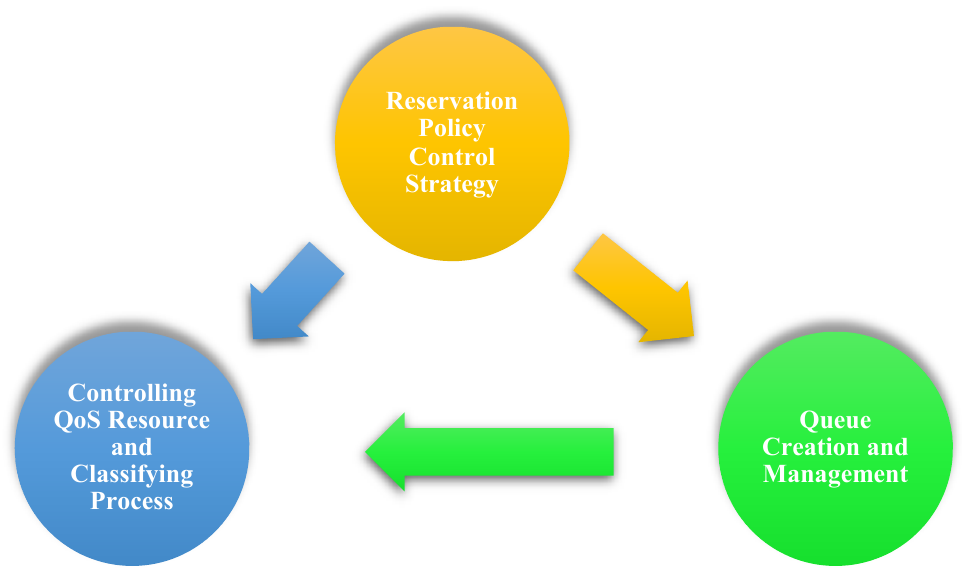
Figure 3. The main components of resource reservation approach.